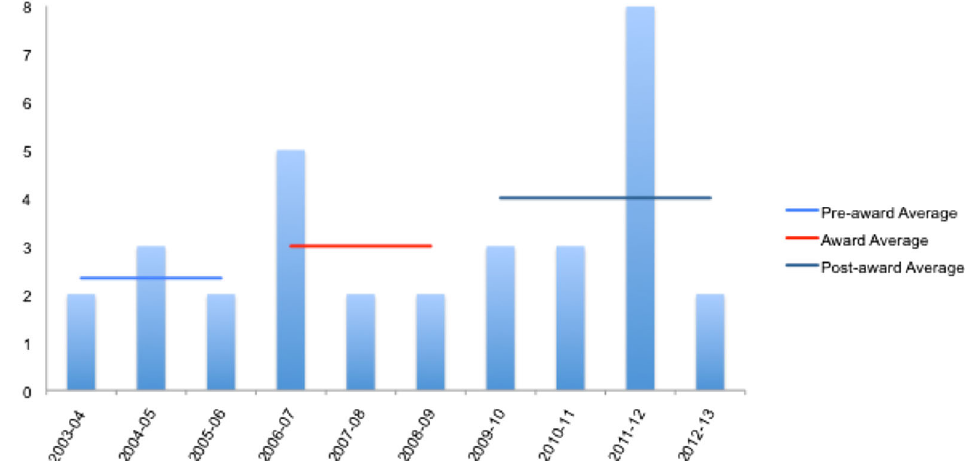
FIG. 8. PhysTEC secondary graduates from Seattle Pacific University (SPU).